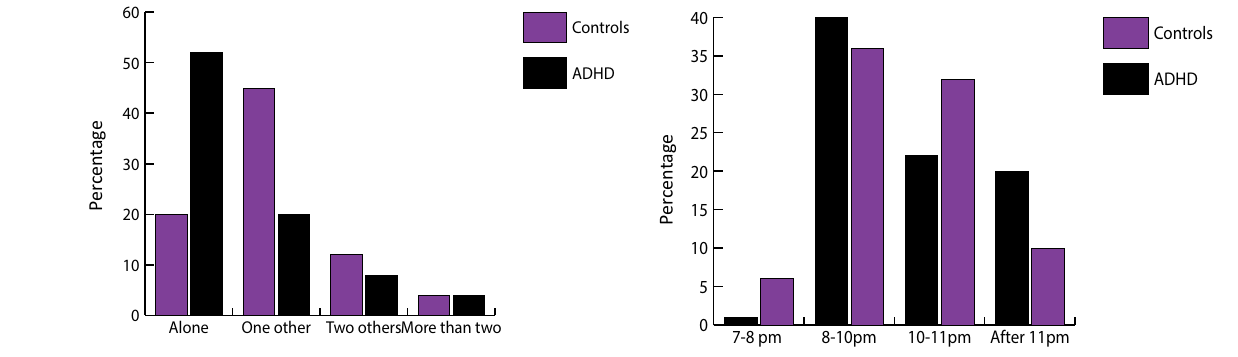
Fig. 1 Comparison of sleeping arrangements Fig. 2 Routine bedtime during school